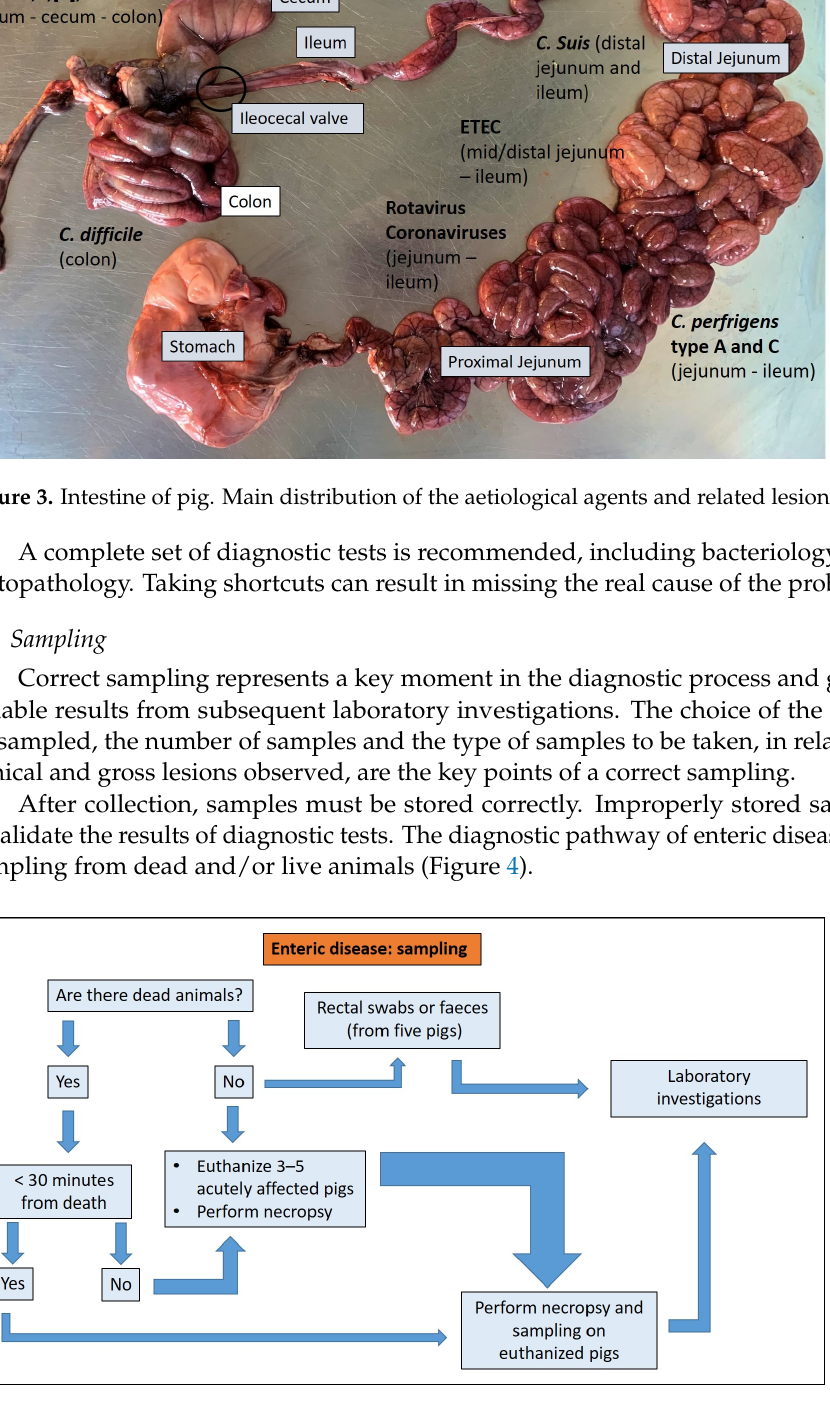
Figure 4. Enteric disease: sampling criteria in the diagnostic pathway.